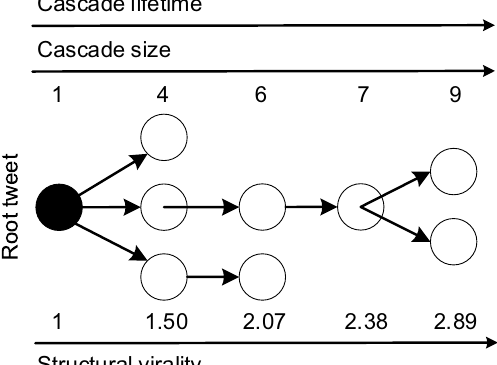
Figure 8. Example tree structure of a rumor